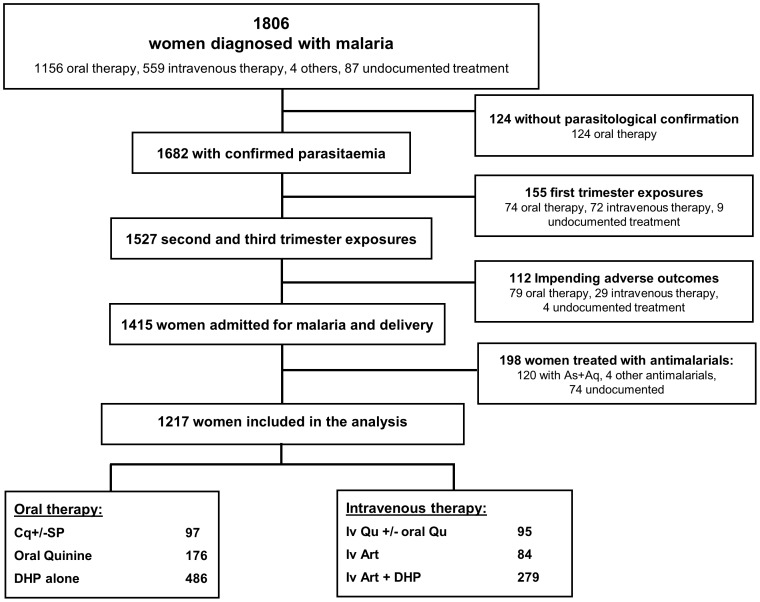
Study Profile: Acute Malaria Treatment.